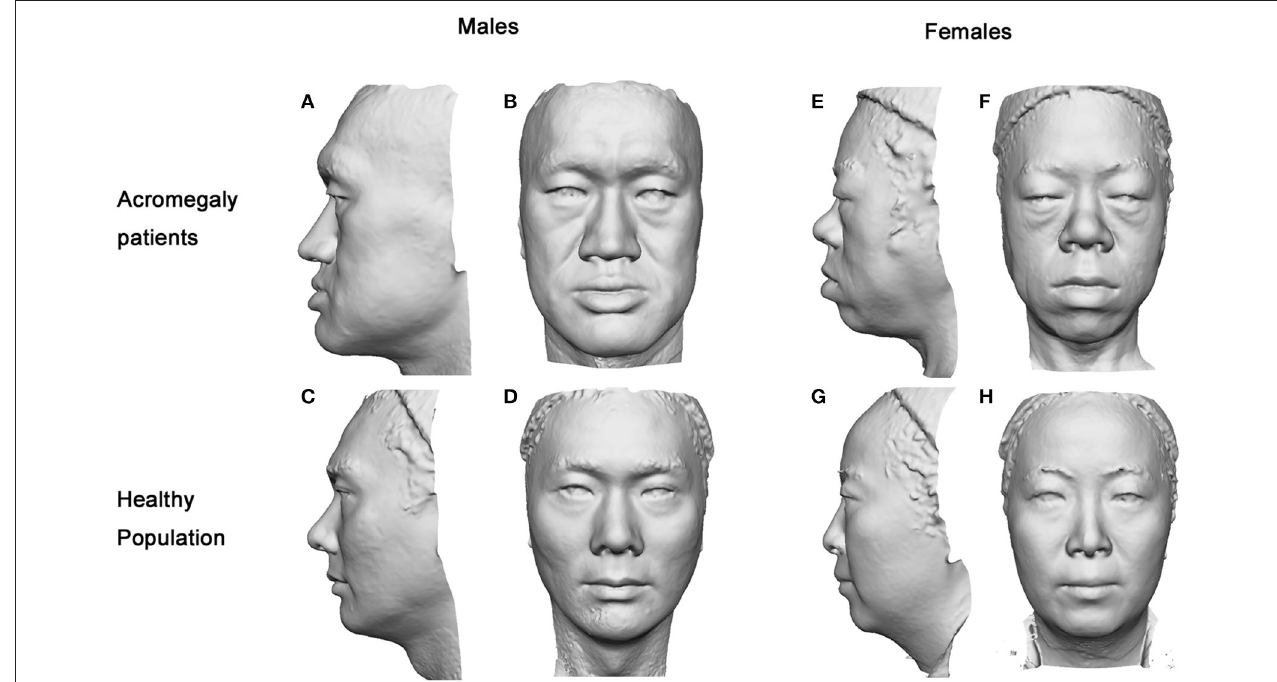
FIGURE 2 | Gray-mode 3D images of the acromegaly patients and healthy controls. The facial characteristics of the acromegaly patients were remarkable as presented in either gender. In male patients (A,B) , the nasofrontal angle and columella-labial angle were smaller, the gonion-gnathion distance was longer, the face contour and nose were larger, and the vermilions were thicker than those of the healthy males (C,D) . In female patients (E,F) , the face contour was more oval, the nose was wider, the nasofrontal angle was smaller, the gonion-gnathion distance was longer, and the vermilions were thicker than those of the healthy females (G,H) .